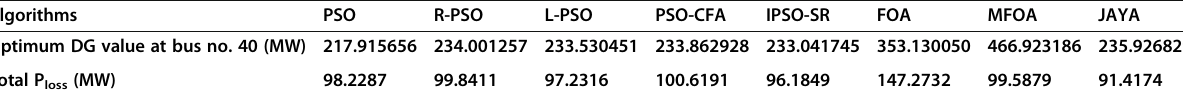
Table 24 Simulation results on the IEEE 118 bus system with DG using different algorithms Algorithms